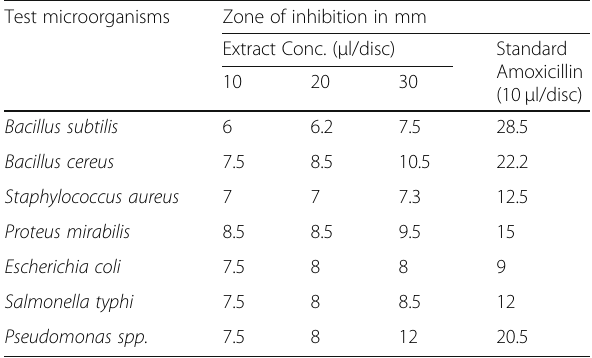
Table 3 Zone of Inhibition produced by LMCA against some Gram positive and Gram negative bacteria Test microorganisms